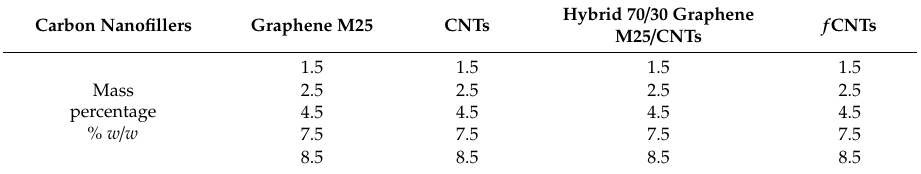
Table 1. Carbon nanofillers and their mass percentages (% w / w ) in the as-prepared polymer composites.